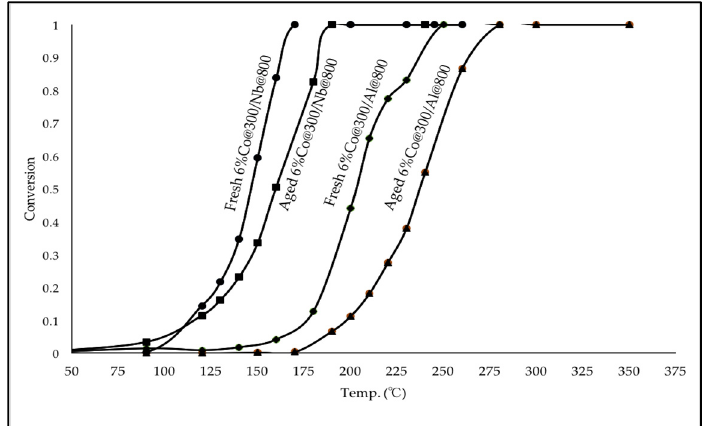
Figure 3. Fresh 6% Co@300/Nb@800, aged 6% Co@300/Nb@800, fresh 6% Co@300/Al@800 and aged